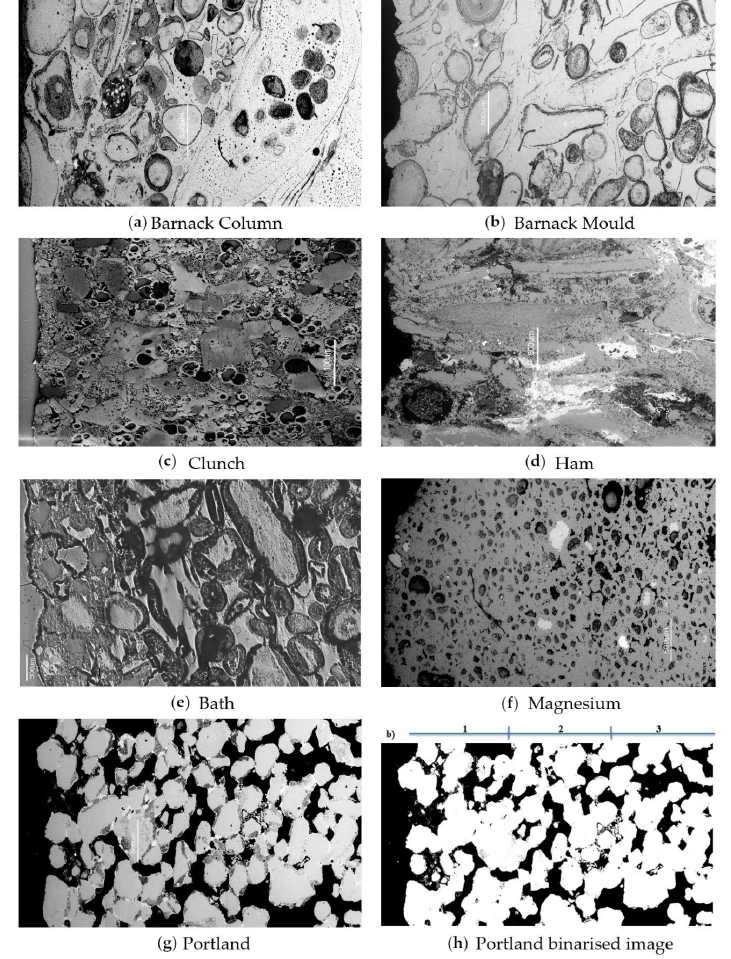
Figure 2. SEM cross-sections of the stone specimens. ( a ) Barnack Column, ( b ) Barnack Mould, ( c ) Clunch, ( d ) Ham, ( e ) Bath, ( f ) Magnesian, ( g ) Portland, ( h ) Portland image with adjusted threshold showing pores in black and stone in white (5200 µ m × 2500 µ m in × 50 magnification). Surface of stone shown on left hand side of image with 1, 2 and 3 indicating regions of increasing depth from the stone